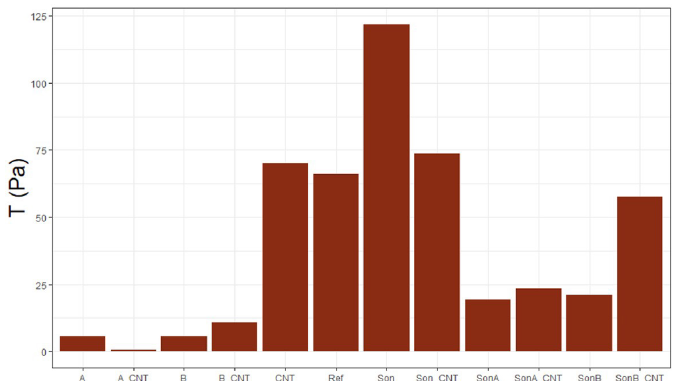
Figure 8. Yield stress of the fresh Portland cement pastes.